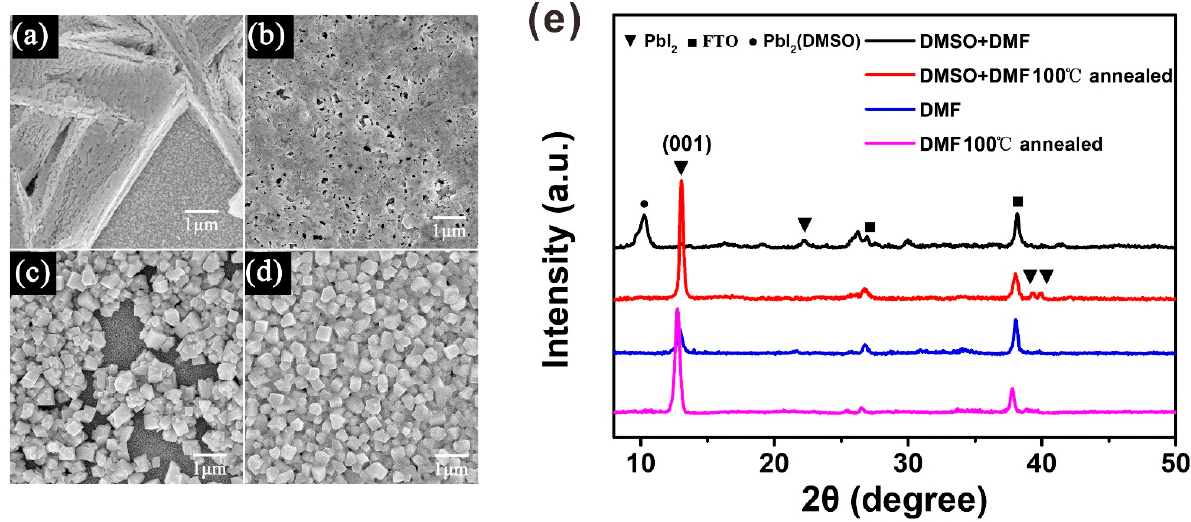
Figure 2. Characterization of PbI 2 and MAPbI 3 perovskite films without and with DMSO. ( a ) The top view image of SEM for PbI 2 film without DMSO. ( b ) The top view image of SEM for PbI 2 film with DMSO. ( c ) MAPbI 3 SEM top view image corresponding to PbI 2 film without DMSO. ( d ) MAPbI 3 SEM top view image corresponding to PbI 2 film with DMSO. ( e ) XRD patterns of PbI 2 films without and with